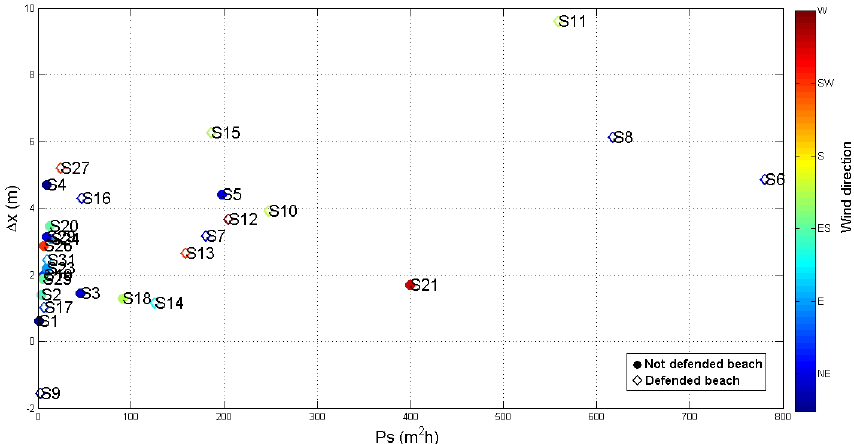
Figure 15. Relationship between P s and shoreline